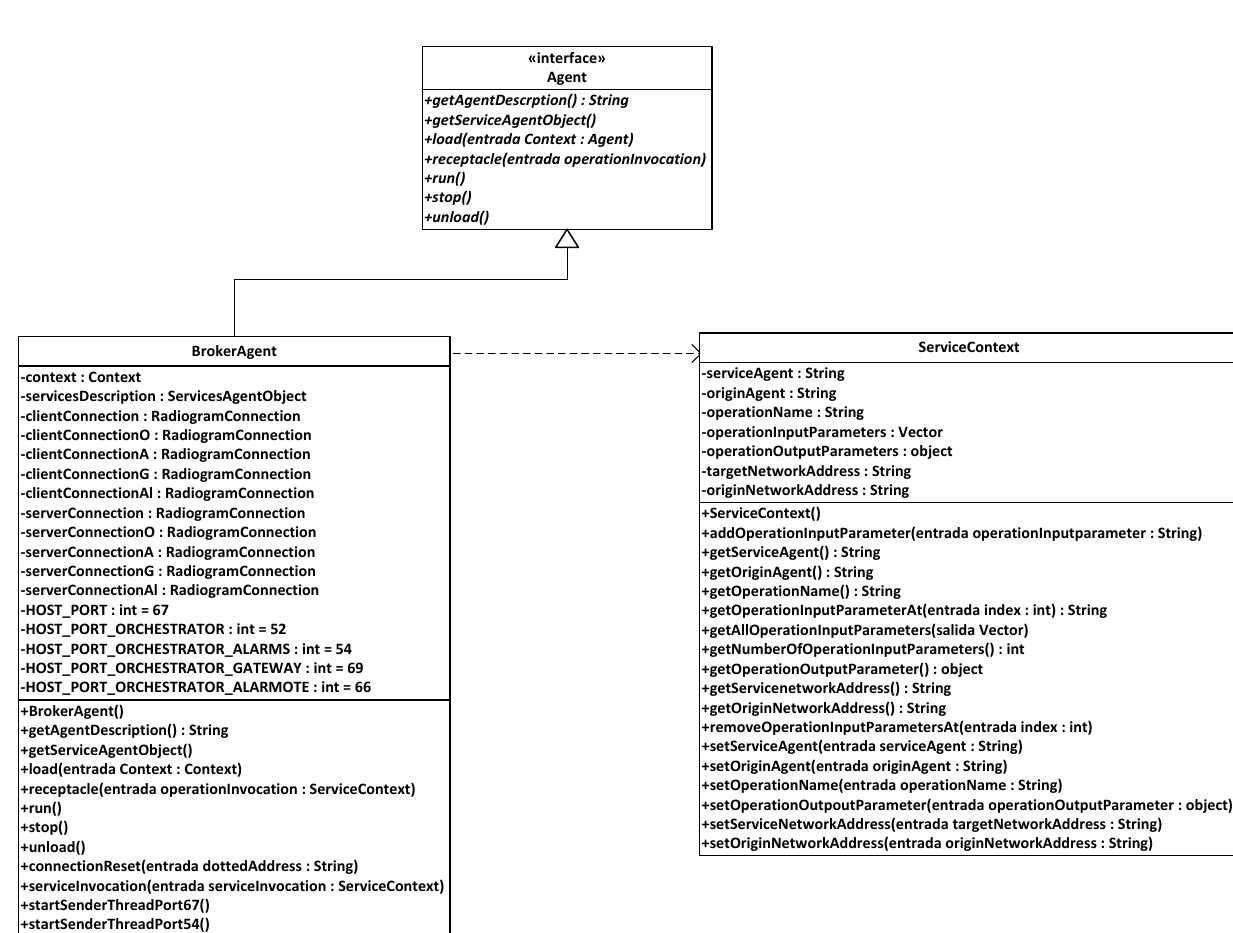
Figure 14. Class diagram of the